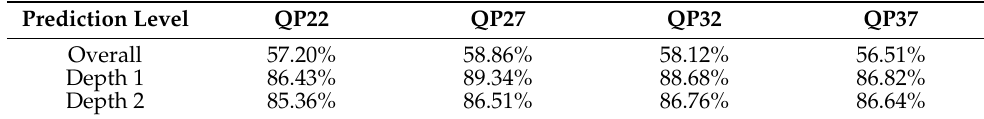
Table 6. Prediction accuracy from different levels of four ResNets.